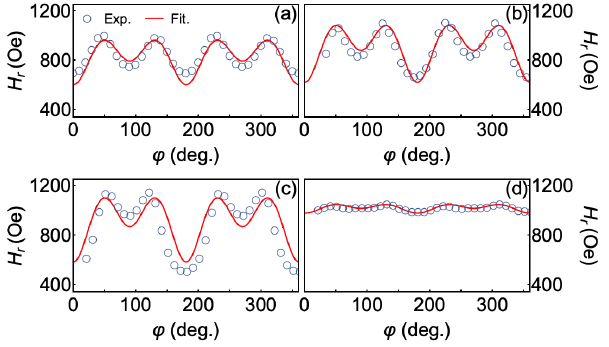
Figure 4. Angular dependence of the resonance field H r obtained from the FMR absorption derivative signal measured for the Co 2 FeAl/W bilayers in which the CFA layer was grown at ( a ) 300 K, ( b ) 573 K, ( c ) 673 K, and ( d ) 773 K. The red lines are fittings obtained with Equations (6) and